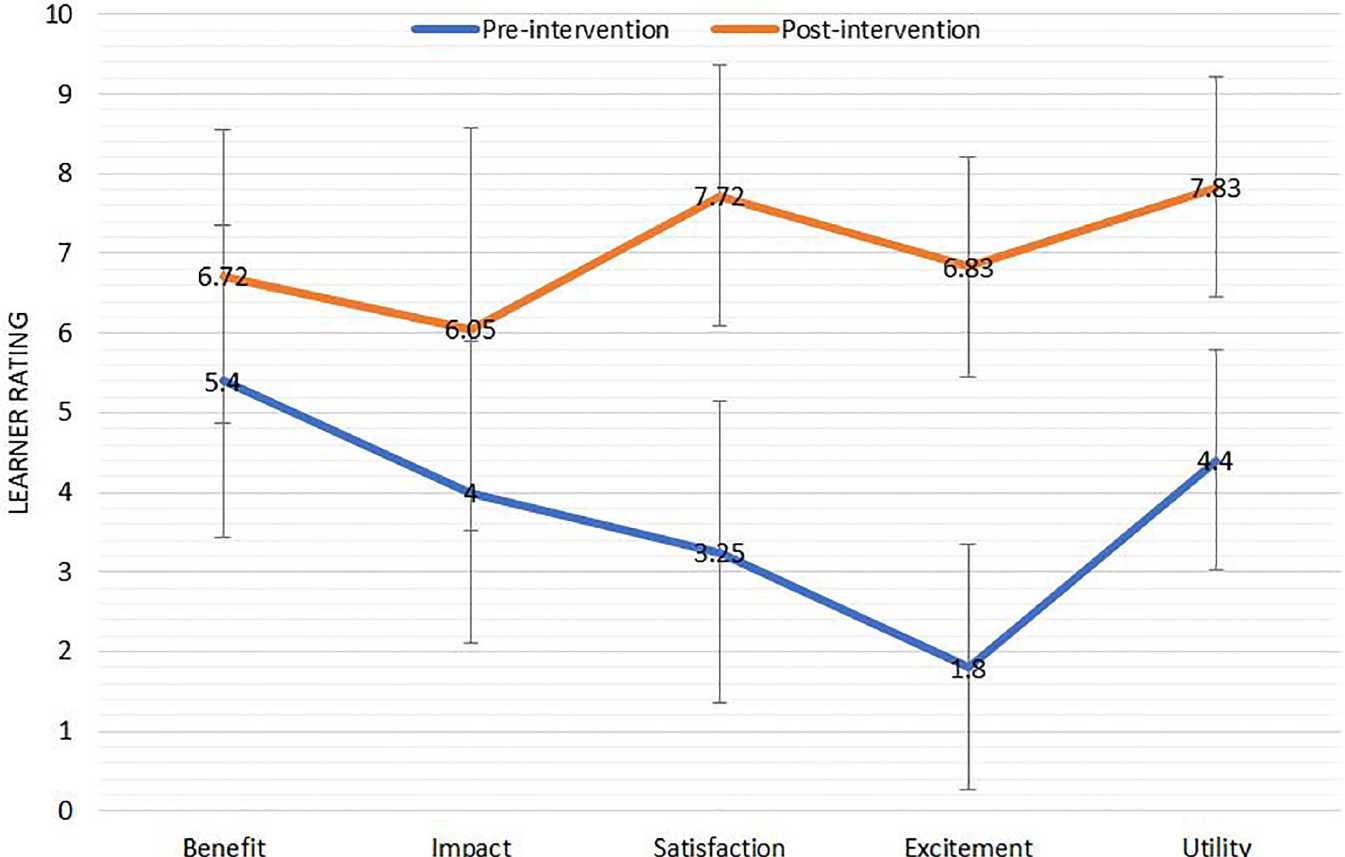
Figure. Learner ratings of the reading curriculum before and after the intervention. Average values are reported with error bars repre- senting one standard deviation above and below the